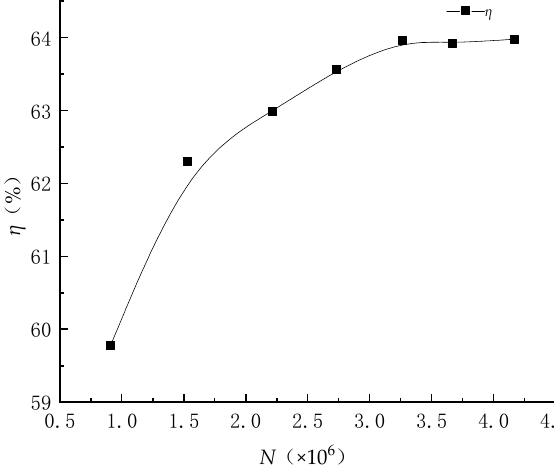
Figure 3. Grid irrelevance analysis diagram.